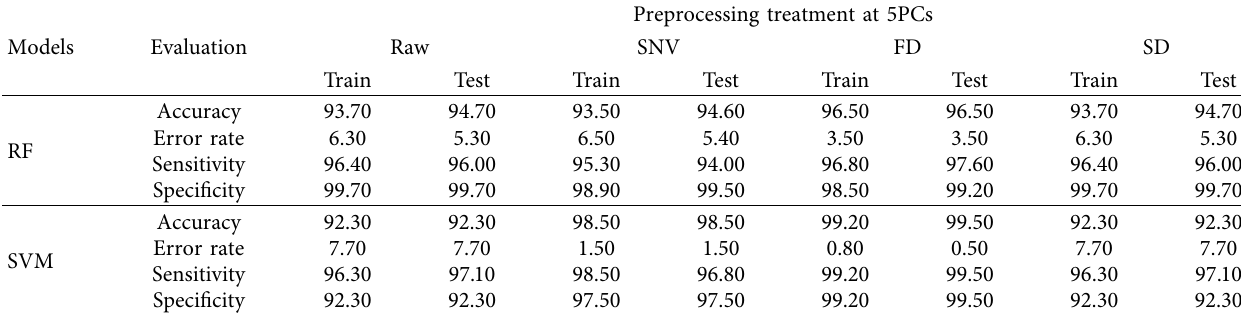
Table 2: Te infuence of preprocessing technique on identifcation models (fertilizer A).